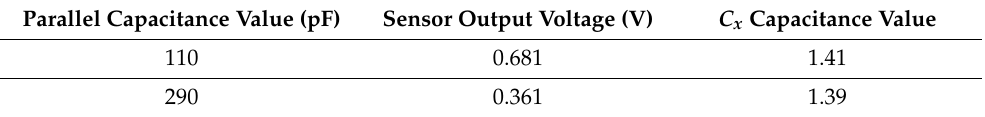
Figure 14. Measurement system equivalent model: ( a ) sensor measurement system equivalent cir- cuit; ( b ) frequency response curve.